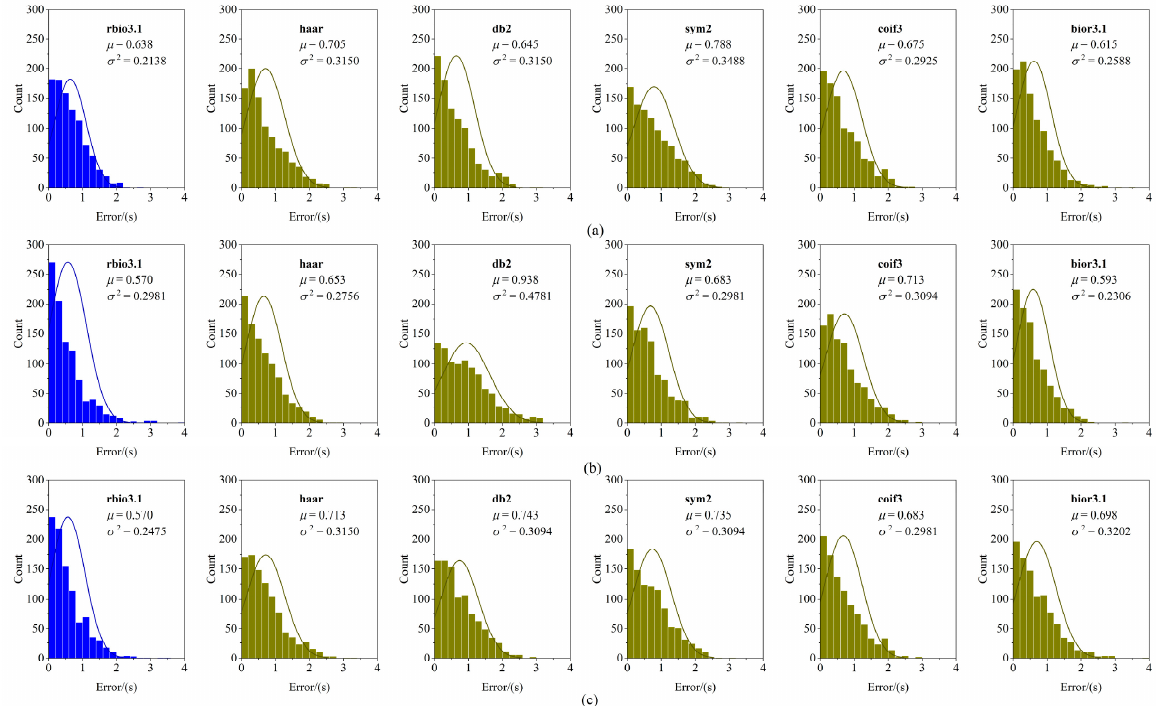
Figure 8. The automatic seismic P arrival picking results using wavelet packet decomposition and deep learning. ( a ) The first round of comparison experiments. ( b ) The second round of comparison experiments. ( c ) The third round of comparison experiments. Each round of comparison experiments contains the rbio3.1 wavelet selected by our method (blue) and five randomly selected wavelets (yellow).